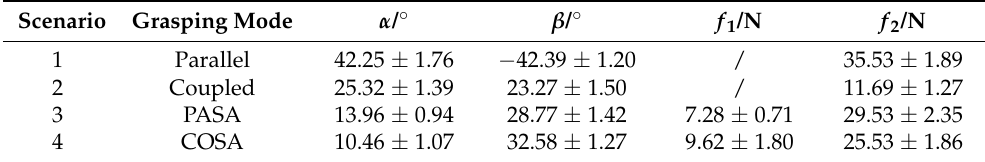
Table 3. Grasping force of the ESMGM hand during grasping experiments.